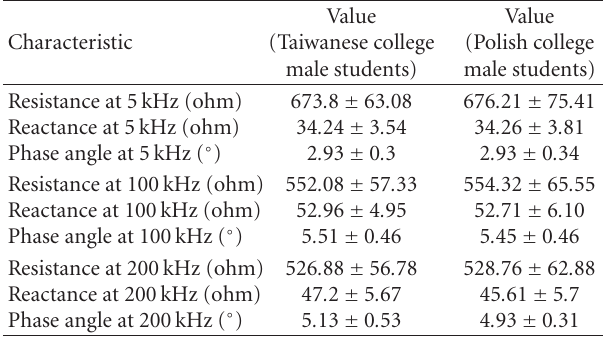
Table 2: Electrical tissue properties characteristics of the Taiwanese and Polish college male students 1 .